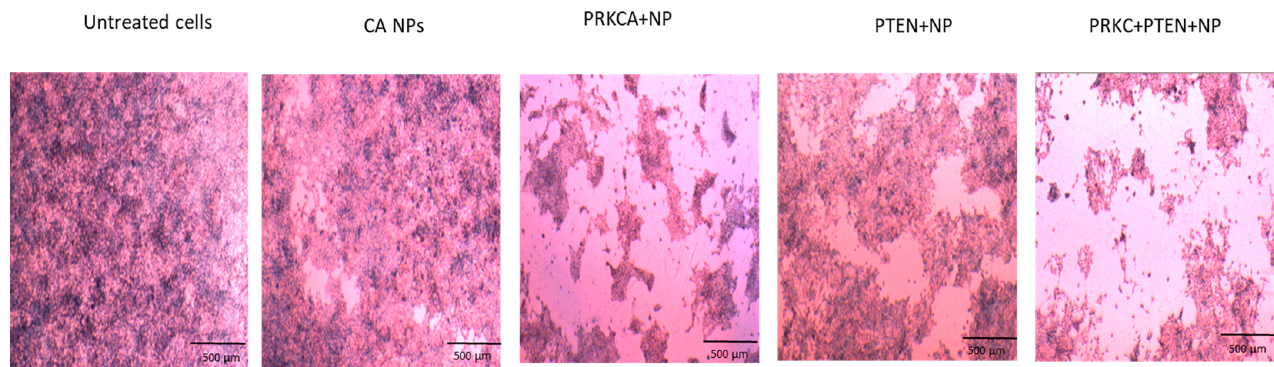
Figure 2. Light microscopic images of MCF-7 cell line following treatment with CA NPs, PRKCA siRNA+NPs, PTEN plasmid+NPs and PRKCA siRNA+PTEN plasmid+NPs. The scale bars set at 500 μ m.